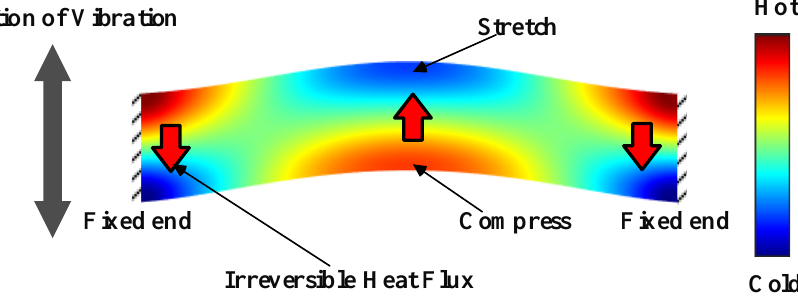
Figure 1. Sketch map of the regime of thermoelastic damping (TED). As the clamped-clamped microbeam resonator vibrates in a purely flexural mode, one side along the thickness of the beam stretches, which causes the temperature of the region to decrease. The temperature of the compressed side increases, causing a temperature gradient along the thickness of the beam. The irreversible heat flux induced by the temperature gradient causes the dissipation of